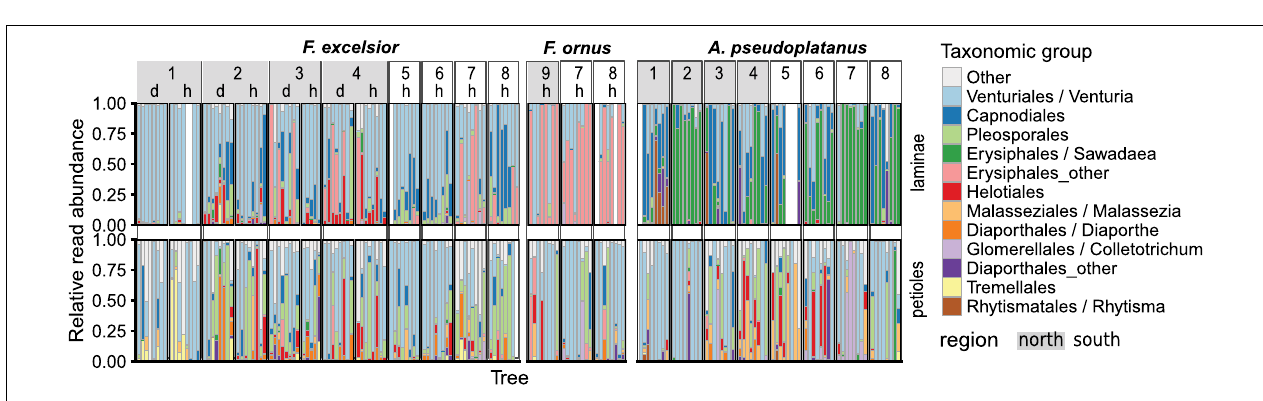
FIGURE 4 | Relative abundances of the most frequently encountered fungal taxonomic groups, summarized at the order level. If > 75% of all reads in an order belonged to a specific genus, then this genus was used as group instead and the remaining OTUs were classified as “Other.” The frequencies are shown for each host species and leaf part (vertical panels) for different sampling sites (1–9) and health status (h, healthy; d, diseased).